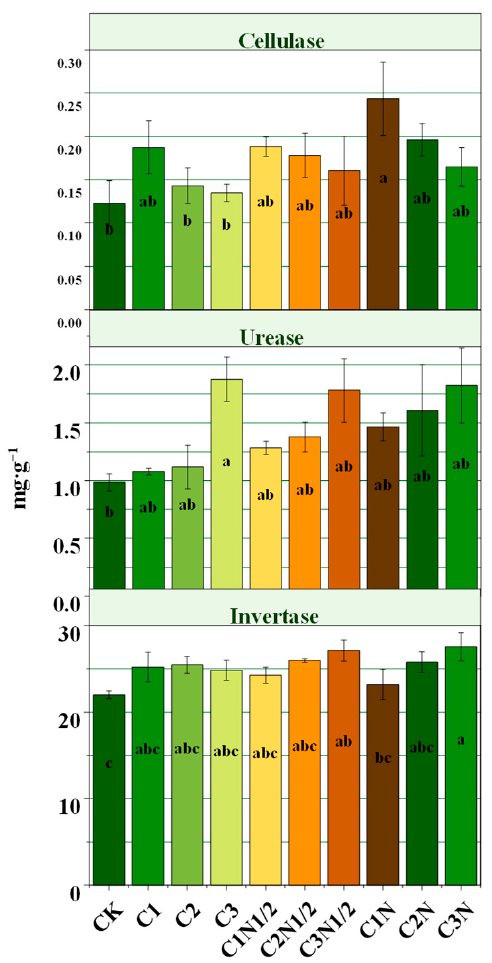
Figure 2. Soil enzyme activity under different treatments. Different letters indicate statistically significant ( p < 0.05) differences between treatments